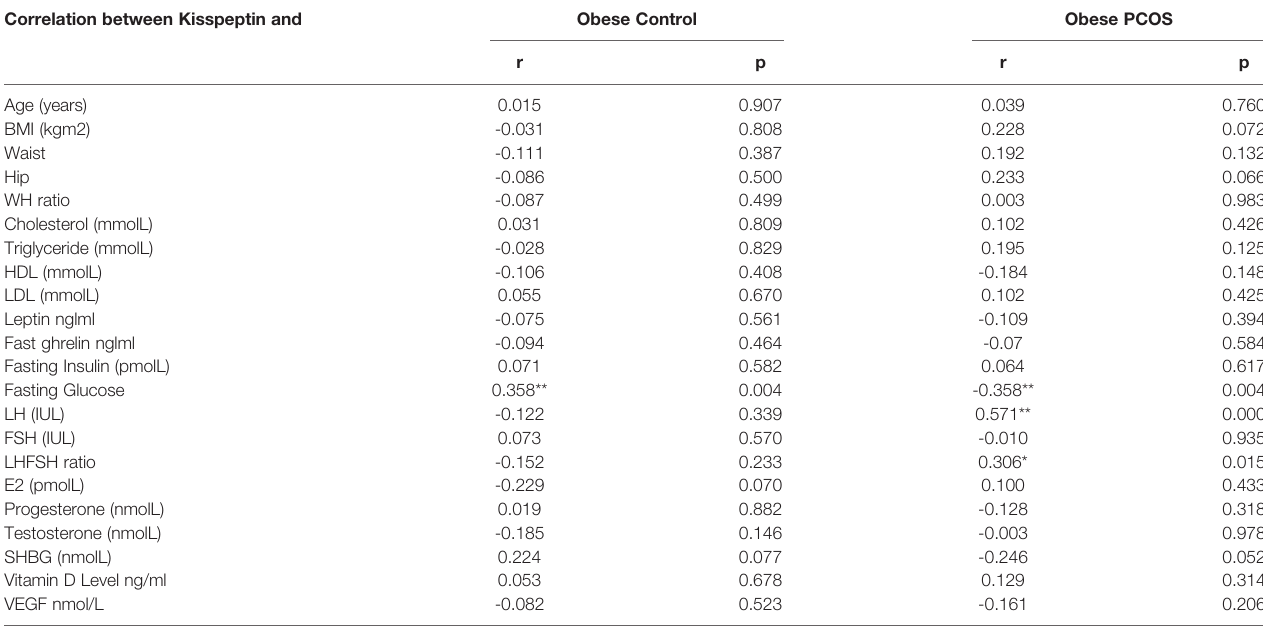
TABLE 2 | Correlation between kisspeptin and the studied parameters in the obese PCOS patients and obese control group. Correlation between Kisspeptin and Obese Control